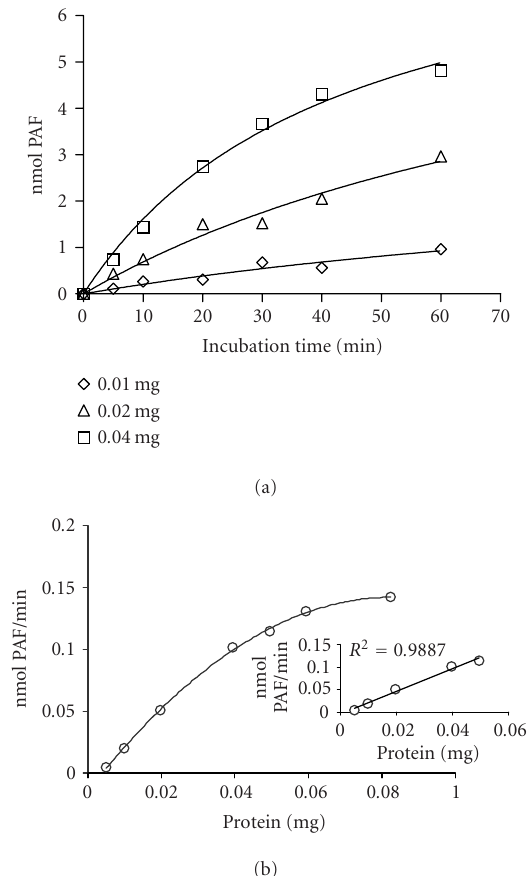
Figure 3. Dependence of PAF formation by incubation time and protein concentration: (a) time course of PAF production us- ing 0 . 01, 0.02, 0.04 mg total protein; (b) lyso-PAF AT activity as a function of protein concentration at a fixed incubation time 30 minutes. Experiments were performed with total membrane fractions of HMC in the present of 20 µ M lyso-PAF and 200 µ M acetyl-CoA. Results are the average of two independent determi- nations using di ff erent enzyme preparations performing dupli- cate samples.